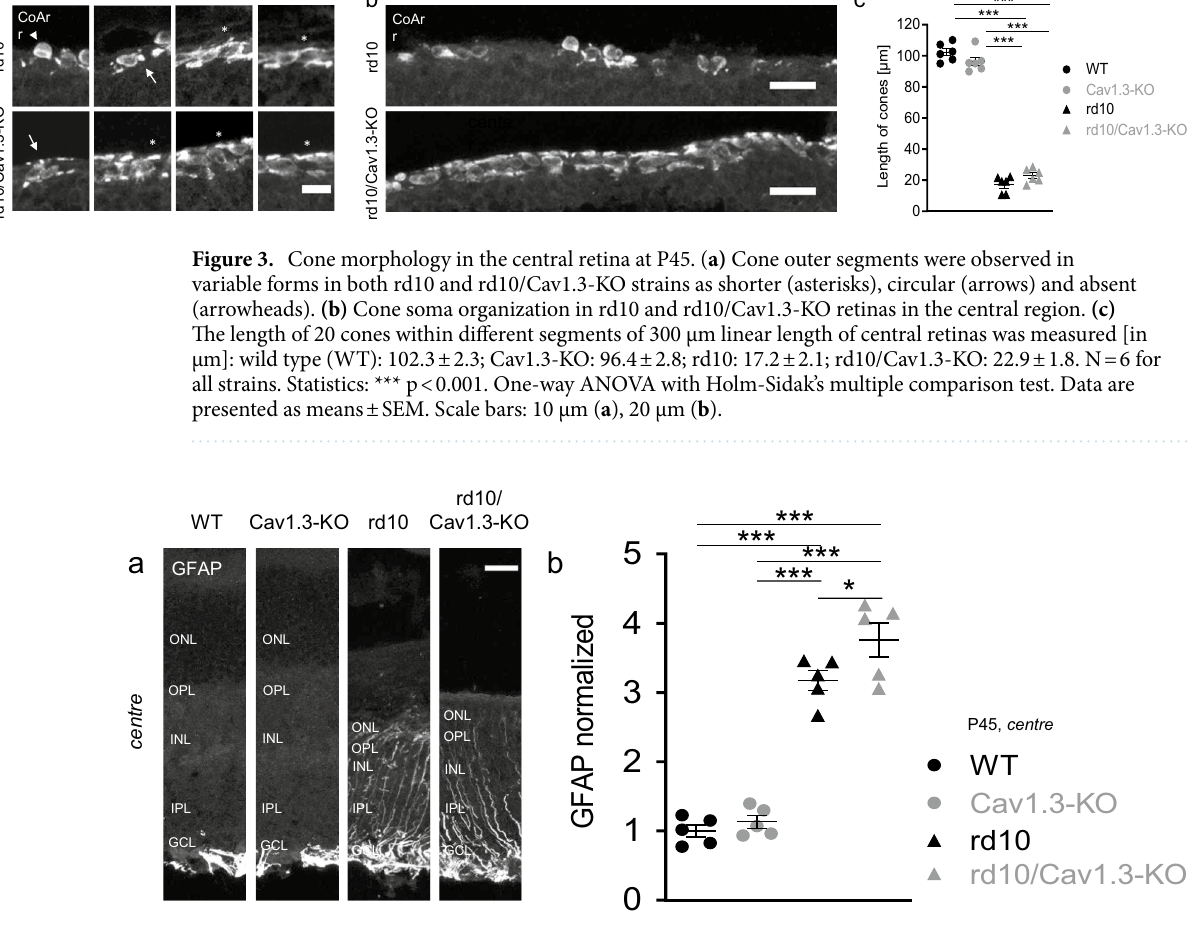
Figure 4. Glial fibrillary acidic protein signal in the central region at P45. (a) Immunoreactivity against glial fibrillary acidic protein illustrates Müller glia cell activation in wild type, Cav1.3-KO, rd10 and rd10/Cav1.3-KO retinas in the central region at P45. (b) The GFAP signal in the central region of Cav1.3-KO, rd10 and rd10/ Cav1.3-KO retinas was normalized to wild type: Cav1.3-KO: 1.1 ± 0.1; rd10: 3.2 ± 0.1; rd10/Cav1.3-KO: 3.8 ± 0.2. N = 5 for all strains. Statistics: *** p < 0.001. One-way ANOVA with Holm-Sidak’s multiple comparison test. Data are presented as means ± SEM. Scale bars: 20